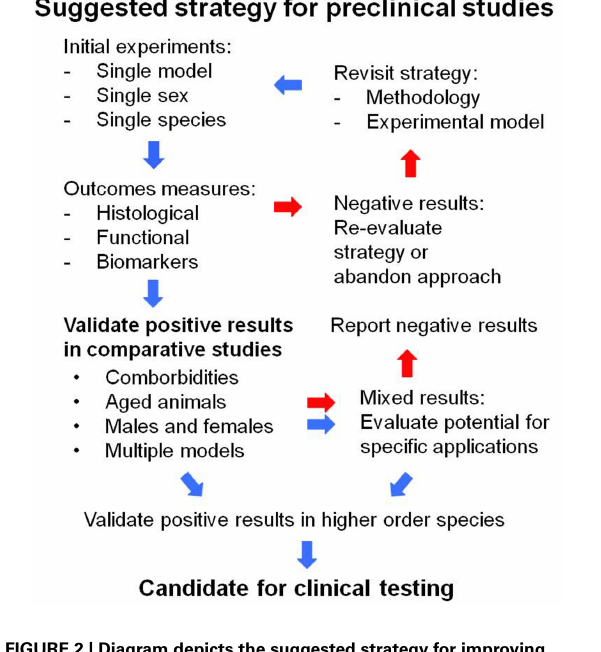
FIGURE 2 | Diagram depicts the suggested strategy for improving translational studies using preclinical models. For testing novel therapeutics, initial experiments that do not show efficacy should be re-evaluated for methodological soundness, and in the absence of experimental flaws, these treatment strategies should be abandoned. Studies that demonstrate efficacy in single models, sexes, or species should be regarded as preliminary and subsequently validated with more rigorous, comparative studies.The suggested validation approach involves comparisons between sexes, distinct ICH models, aged animals, and comorbid conditions that are common in the clinical setting prior to testing in higher order species. Due to the heterogeneity of patient populations, mixed results from validation studies should be subjected to additional evaluations, when appropriate, for application to specific patient cohorts. Negative data should be reported in all instances to guide the field with future